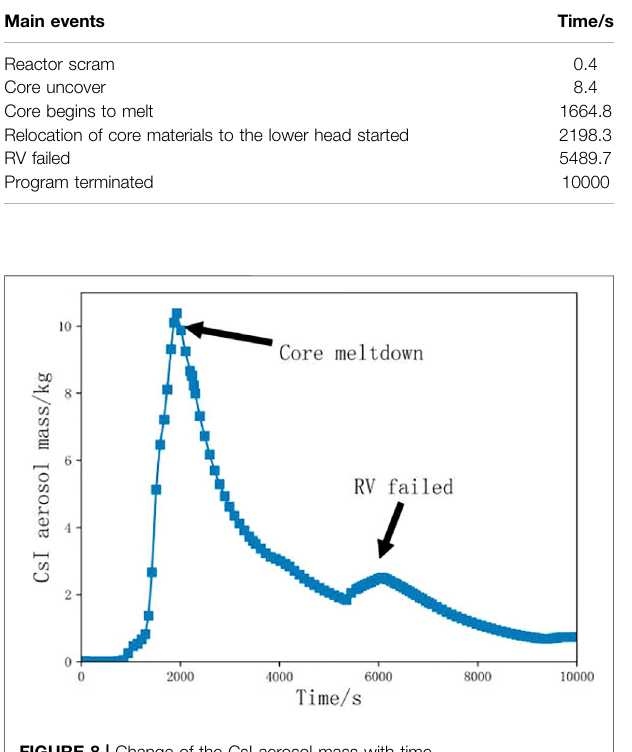
FIGURE 8 | Change of the CsI aerosol mass with time.